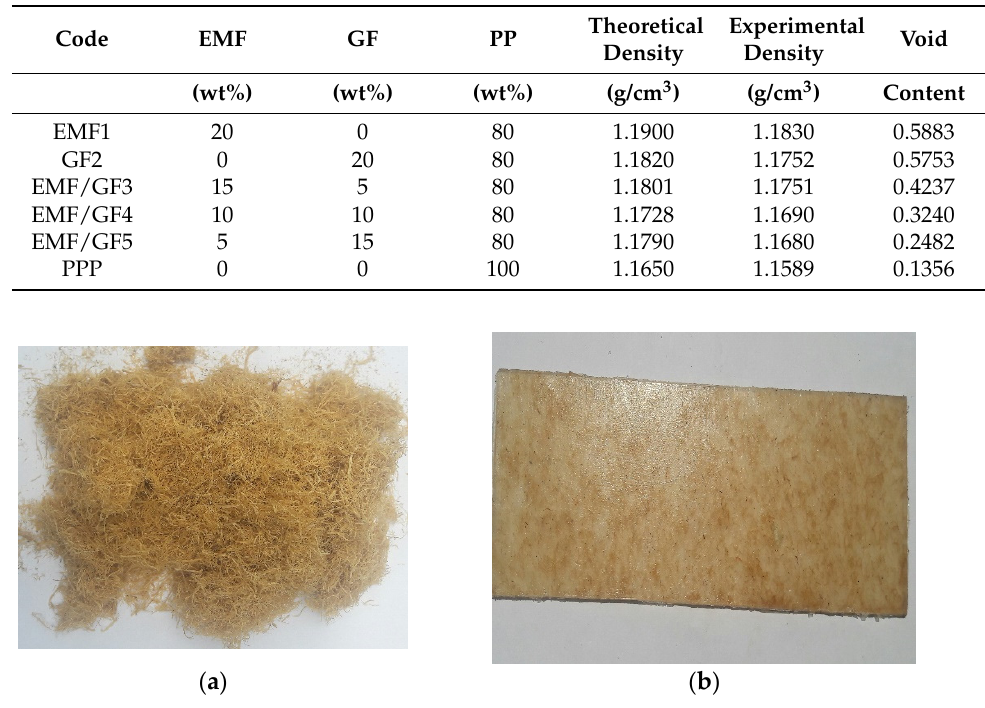
Table 1. Percentage weight ratio, theoretical density and experimental density of composites.